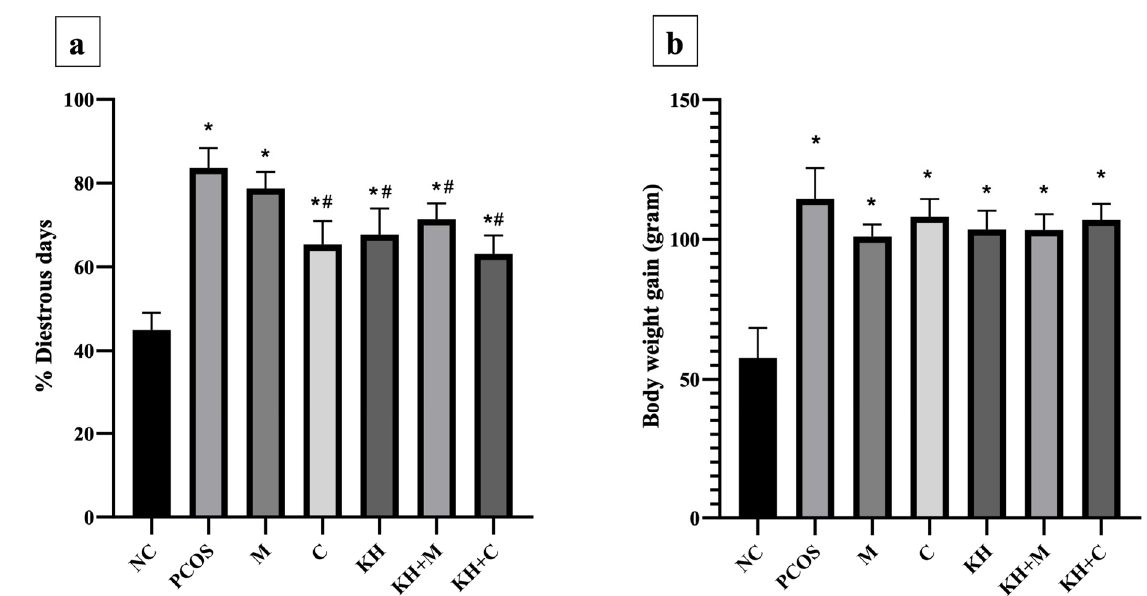
Figure 4. Effects of KH on ( a ) the percentage of dioestrus days and ( b ) rat body weight gain. NC: normal control; PCOS: Untreated PCOS; M: PCOS + Metformin; C: PCOS + Clomiphene; KH: PCOS + Kelulut honey; KH + M: PCOS + Kelulut honey + Metformin; KH + C: PCOS + Kelulut honey + Clomiphene. * p < 0.05 significance against the normal control group, # p < 0.05 significance against the untreated PCOS group. n = 6 per treatment